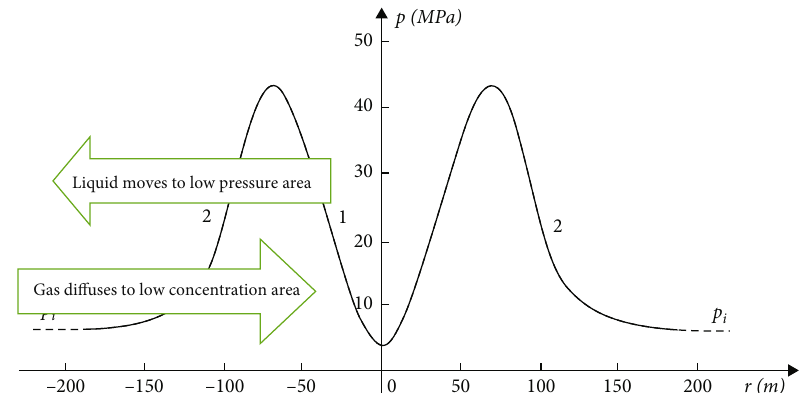
Figure 1: Schematic diagram of double pressure funnels and gas-liquid two-way transfer theory.